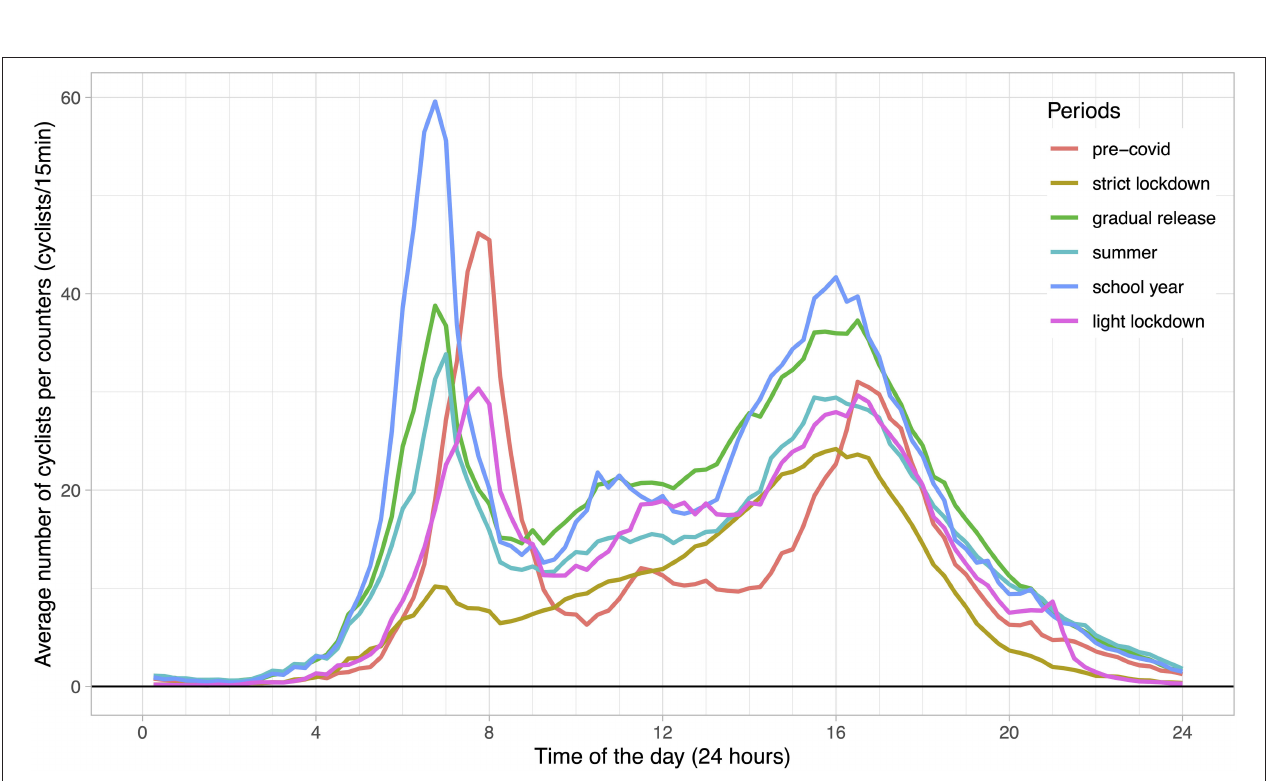
FIGURE 10 | Average bicycle levels per counter during the week and across the day for each of the six periods (data source: Brussels Mobility).